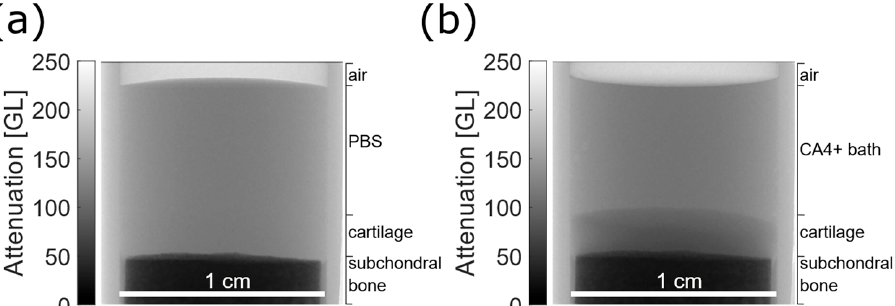
Figure 2. Results from microradiographs. ( a ) Microradiograph of osteochondral plug in PBS bath, prior to CA4+ immersion. Lateral edges are the walls of PMMA sample holder. ( b ) Microradiograph of the same osteochondral plug after 24 h immersion.